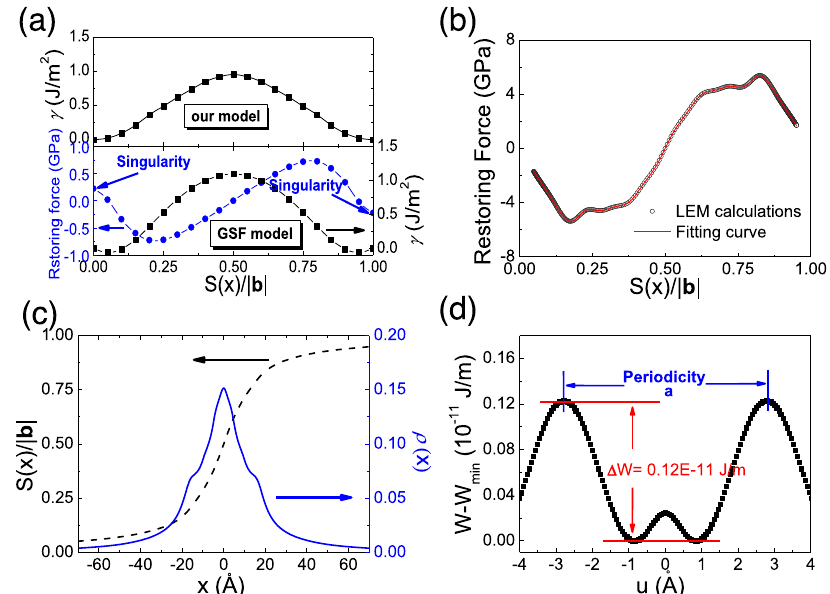
x from the dislocation core. It should be noted that ρ ( x ) refers to the density of in fi nitesimal dislocations in Eq. (1); d variation of the mis fi t energy W as a function oftheposition u ofthedislocationcoreforthe[011](0 (cid:1) 11)edgedislocationofSrTiO 3 with V O . W min =343.74E − 11J/m. Source data are provided as a Source Data fi